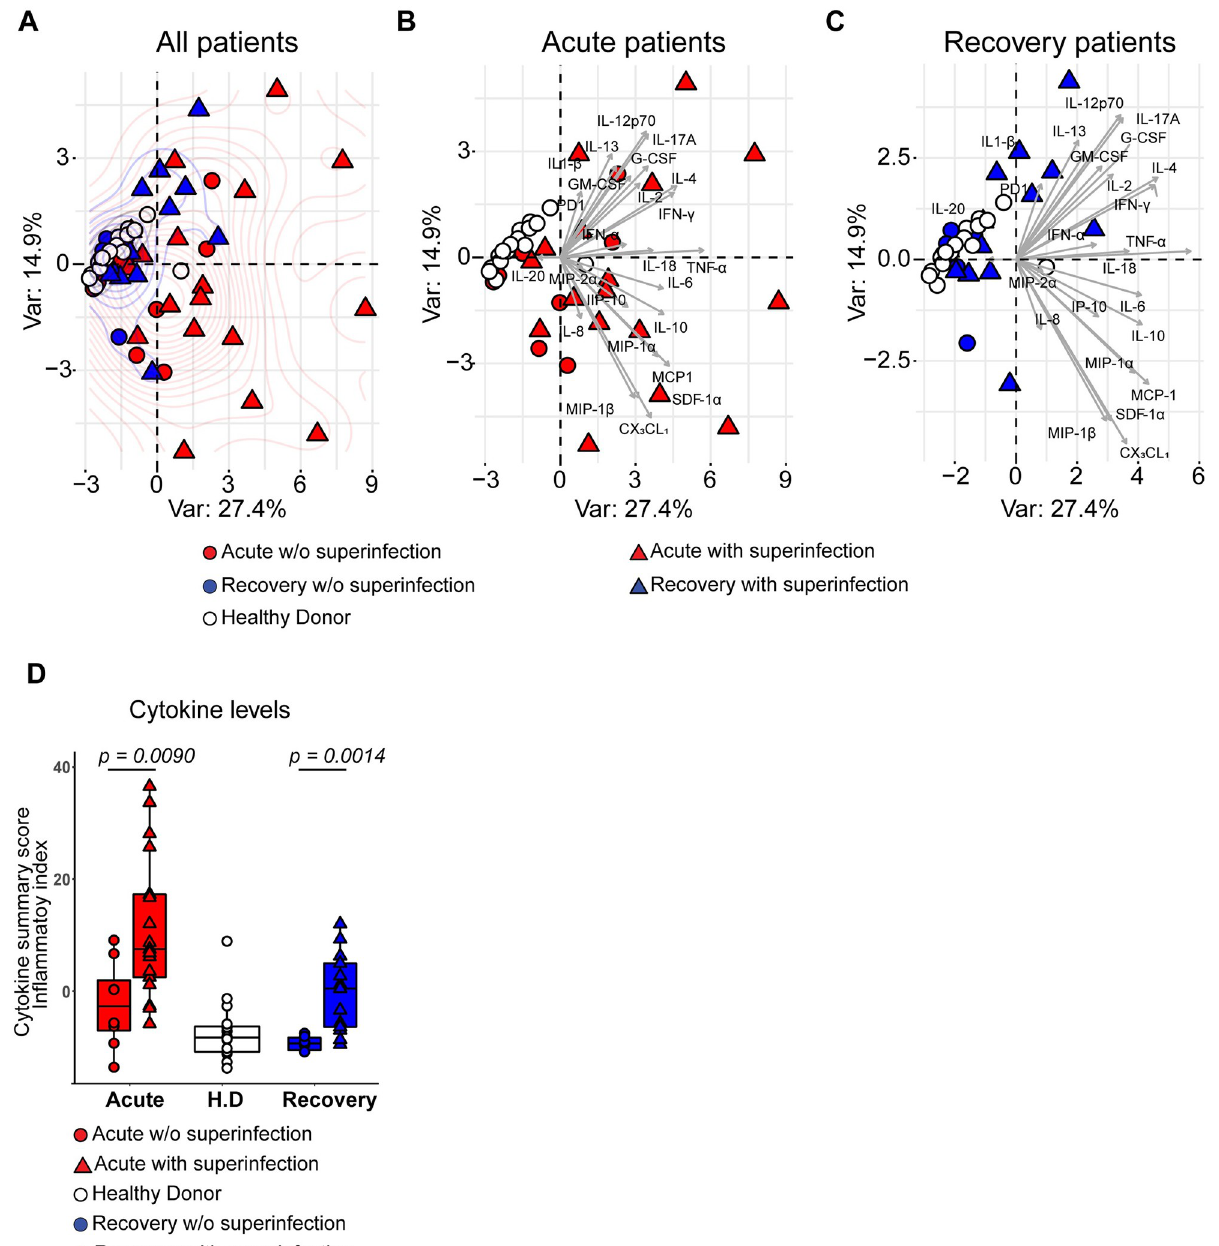
Fig 1. Characterization of inflammatory mediators in COVID-19 plasma and its association with bacterial superinfection. ( A ) PCA of healthy donors (white, n = 17), acute- (red, n = 25) and rec- (blue, n = 19) phase COVID-19 patients grouping the plasma cytokine levels and status of secondary bacterial infections (superinfection). Patients who developed or had bacterial superinfection at the time of sampling are depicted as triangle and patients without (w/o) superinfection as circle symbols. ( B ) PCA of healthy donors (white, n = 17) and acute-phase patients (red, n = 25). Patients who developed bacterial superinfection are depicted as triangle and patients without (w/o) superinfection as circle symbols. ( C ) PCA of healthy donors (white, n = 17), and rec-phase patients (blue, n = 19). Patients with superinfection are depicted as triangle and patients without superinfection as circle symbols. ( D ) Normalized cytokine values (sum of Z-scores) in the plasma of acute (red), rec (blue) patients with or without (w/o) bacterial superinfection and healthy donors (white). Data presented as box plots with box indicating interquartile range and error bars indicating highest and lowest value. For panel D, p values were determined by using Mann-Whitney